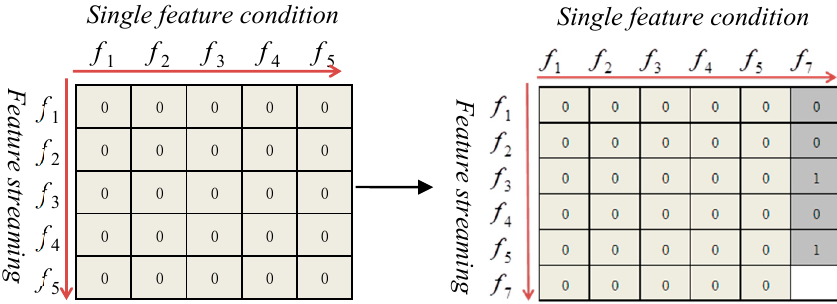
Figure 5. Filtering of single ‐ conditional independence 2.